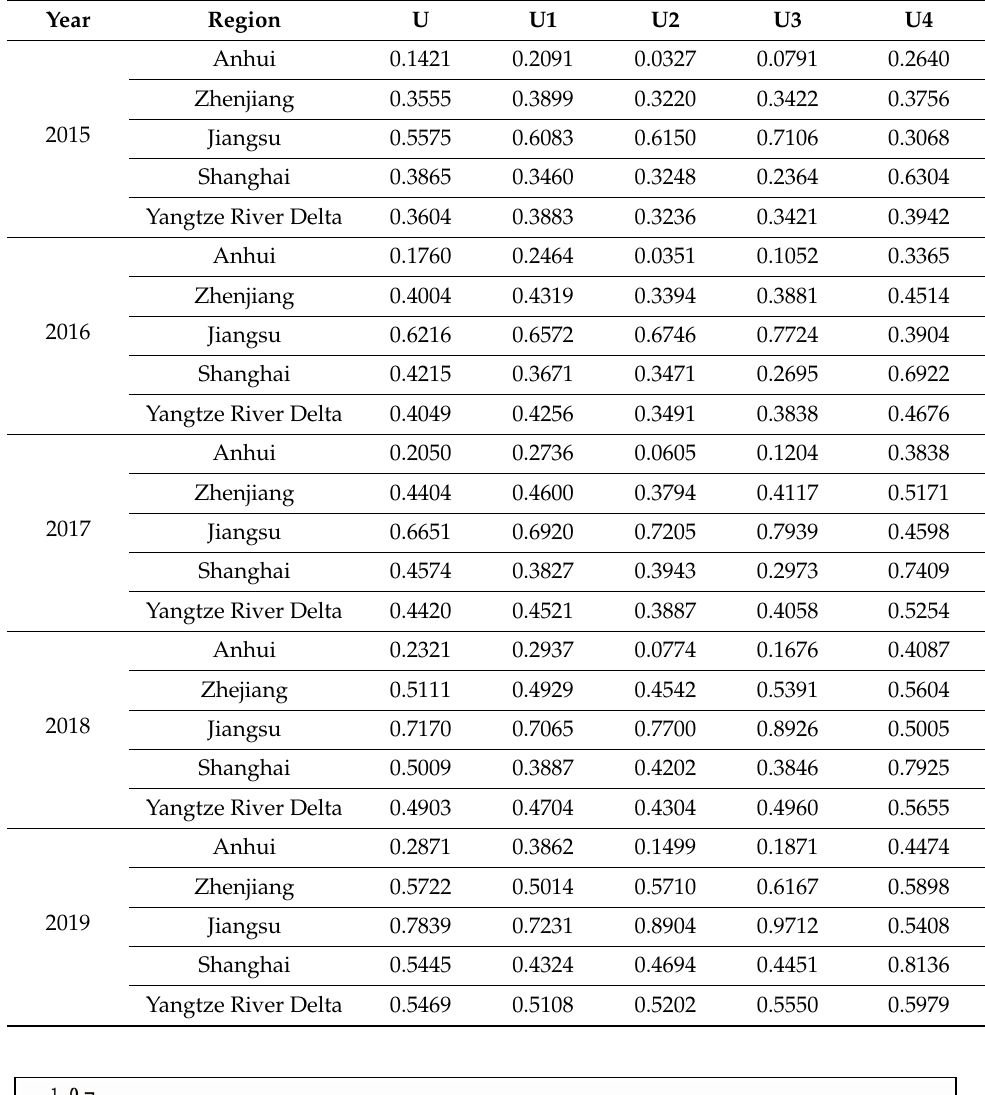
Table 4. Cont . Table 4. Development and comprehensive development indices of the innovation subsystem.